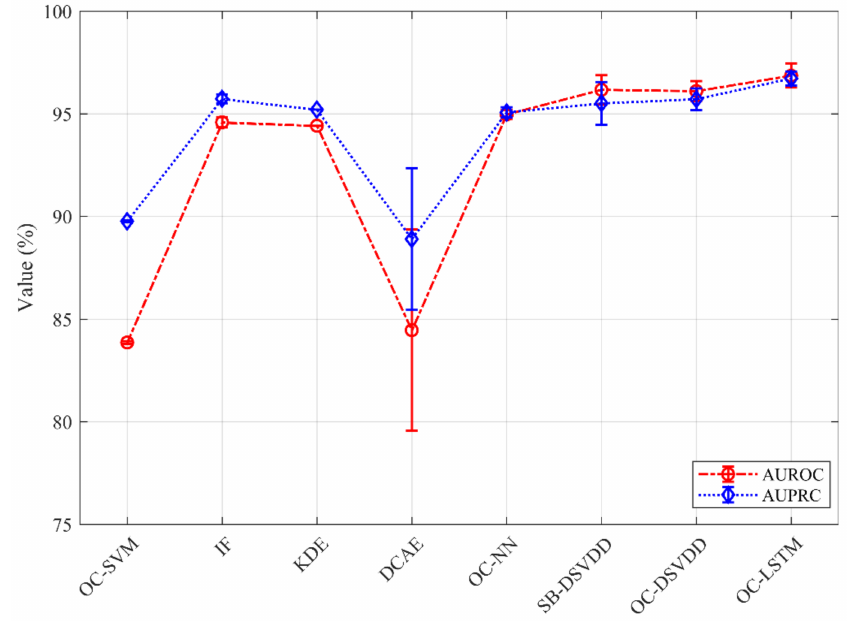
Figure 3. Anomaly detection performance of each model on